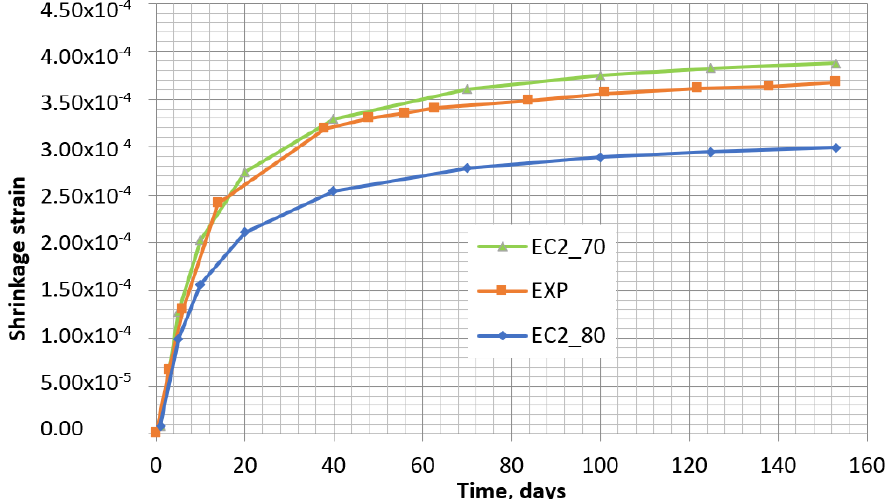
Figure 7. Shrinkage of the control specimen obtained experimentally (EXP) and by EC2 design method, at relative humidity of 70% (EC2_70) and 80% (EC2_80).